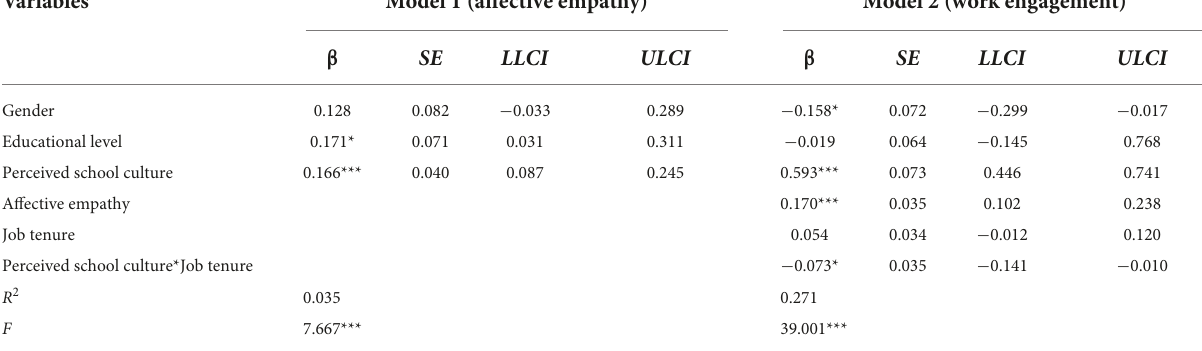
TABLE 3 Testing the moderating role of job tenure in the mediation model. Variables